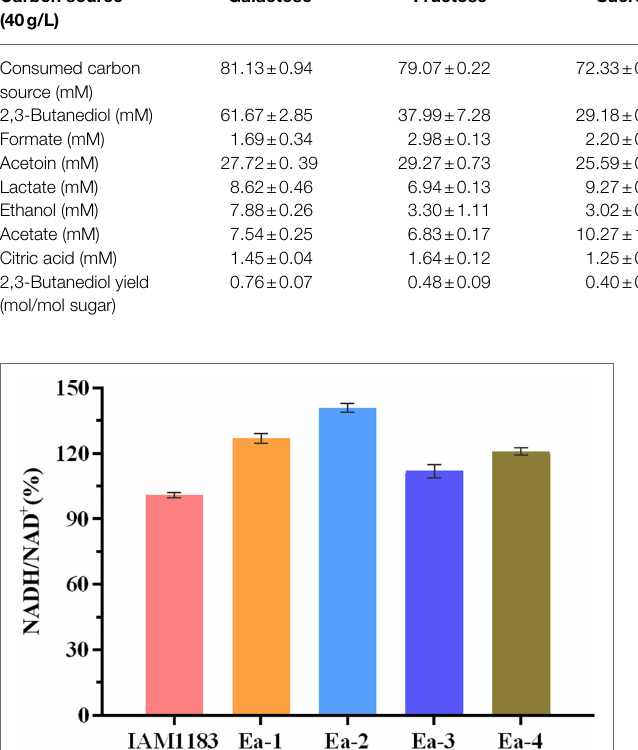
FIGURE 5 | Time profiles of the intracellular NADH/NAD + ratio of the wild- type strain AM1183 and the mutants Ea-1 to -4 ( n = 3). Error bars show the SDs from biological